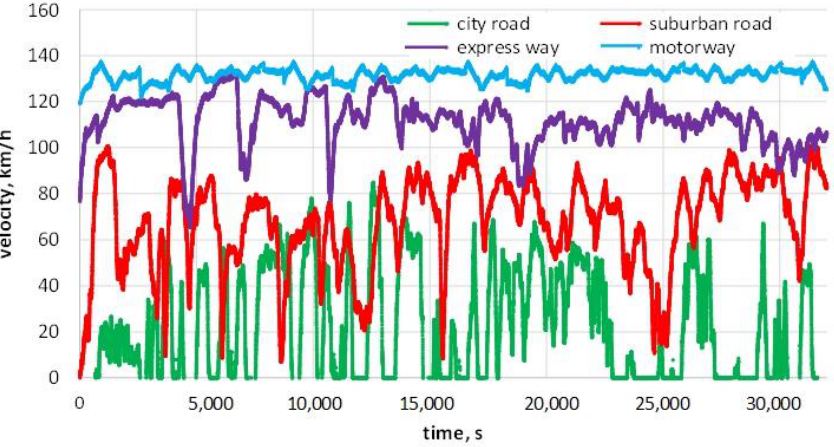
Figure 3. Speed course on the Kielce – Szczecin route at different road sections.